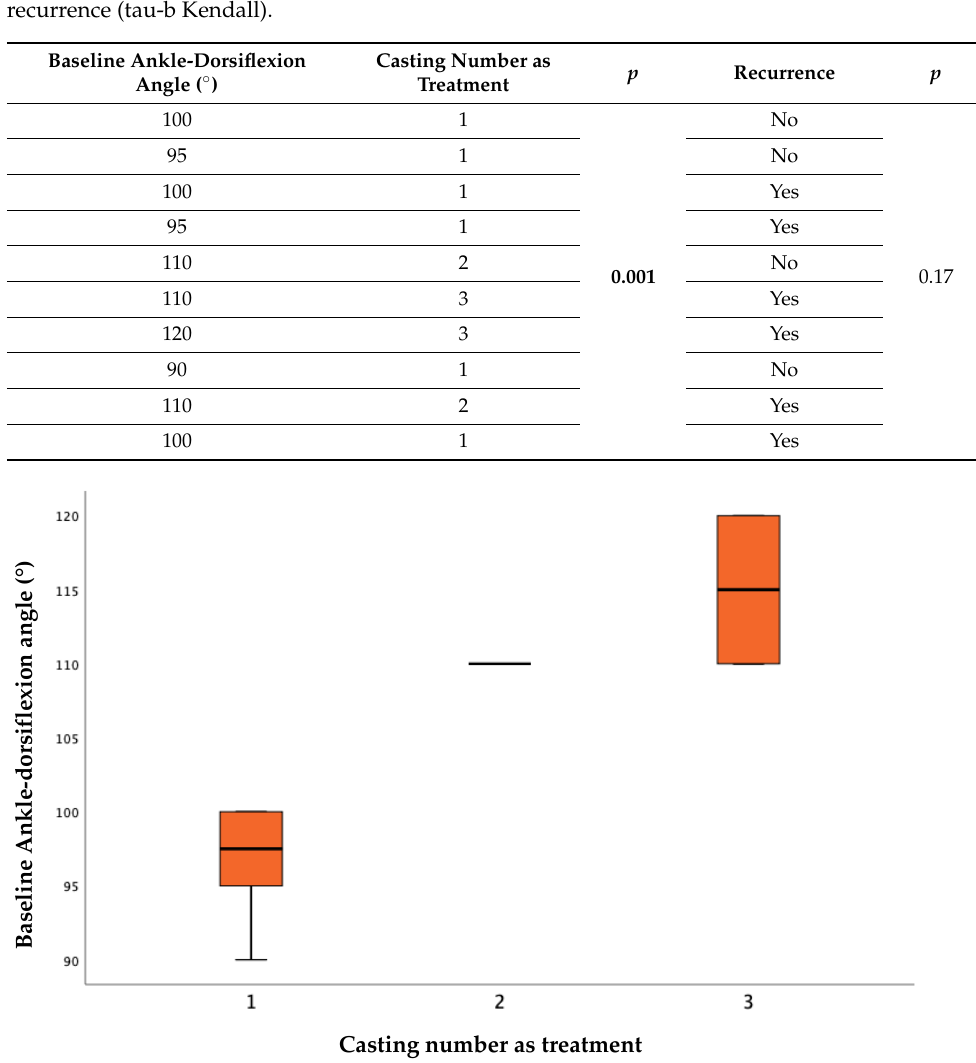
Table 4. Correlation between baseline ankle-dorsiflexion angle ( ◦ ) and casting number as treatment, recurrence (tau-b Kendall).